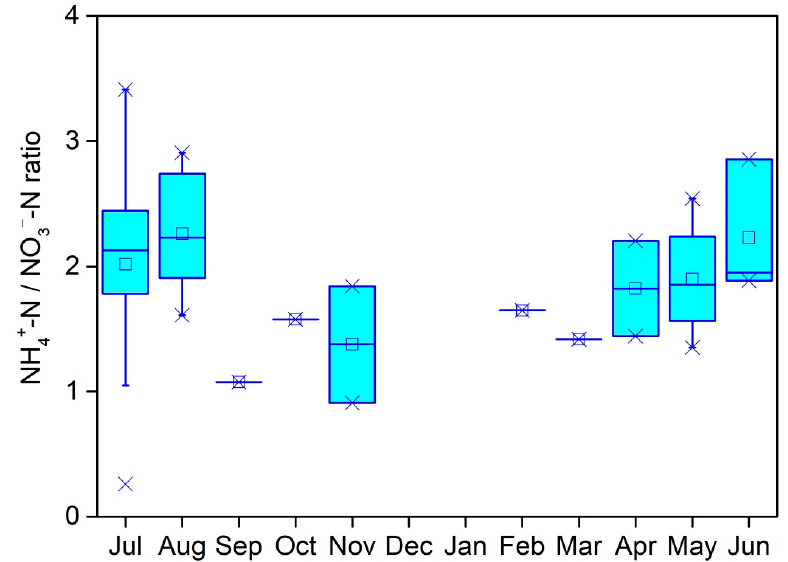
Figure 3. A box chart of the monthly patterns of NH 4+ –N/NO 3 − –N ratios at the DHT reservoir, a rural site in North China from July 2019 to June 2020. There was no precipitation during December 2019 and January 2020. (×: The minimum and maximum values of the NH 4+ –N/NO 3 − –N ratio; the average value; upper and lower edge mean the 25% and 75% value; lines in the box indicate the median value of the NH 4+ –N/NO 3 − –N ratio).